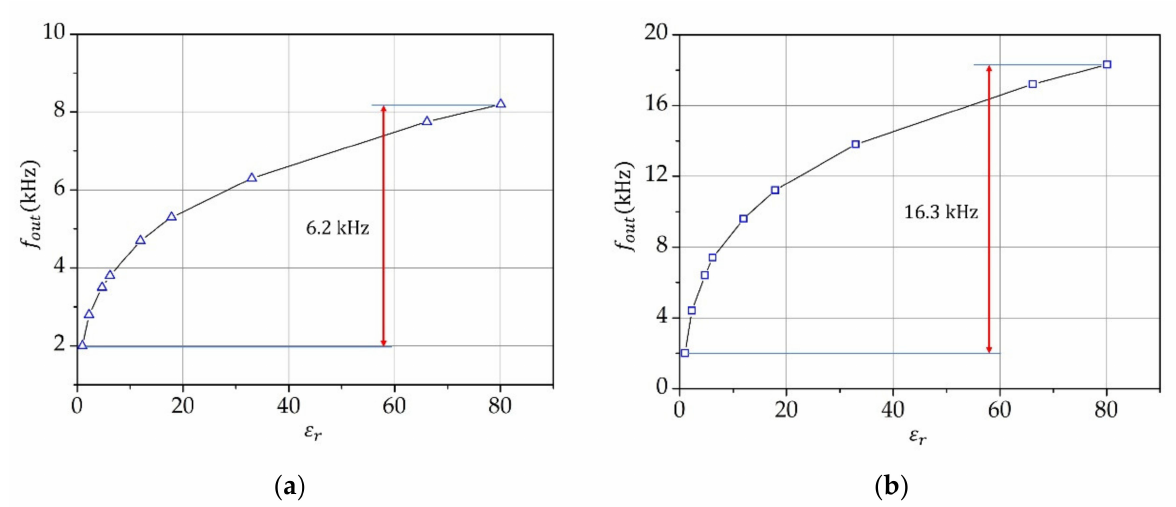
Figure 4. Calibration of measurements of relative permittivity by using pure liquids given in Table 3 at 20 ◦ C at the oscillator frequency ( a ) f osc 1 = 4 MHz (Q data : C 1 = 10 fF, L 1 = 158.314 mH, C 0 = 2 pF) and ( b ) f osc 1 = 10 MHz (Q data : C 1 = 10 fF, L 1 = 25.33 mH, C 0 = 2